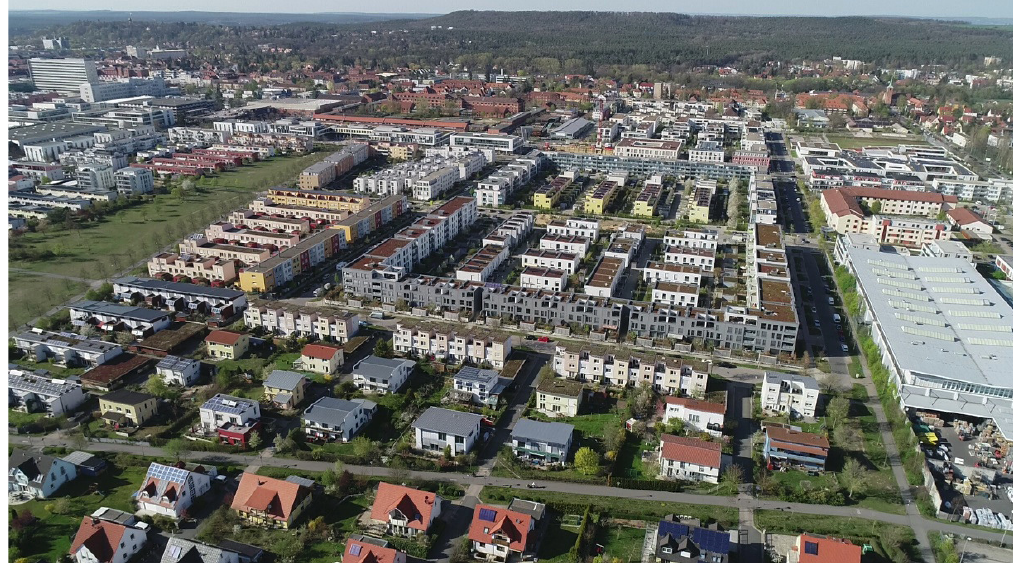
Figure 7. Aerial photo of the studied neighbourhood in Röthelheimpark. Source: Photo courtesy of Jan Gemeinholzer. Urban Planning, 2023, Volume 8, Issue 1, Pages